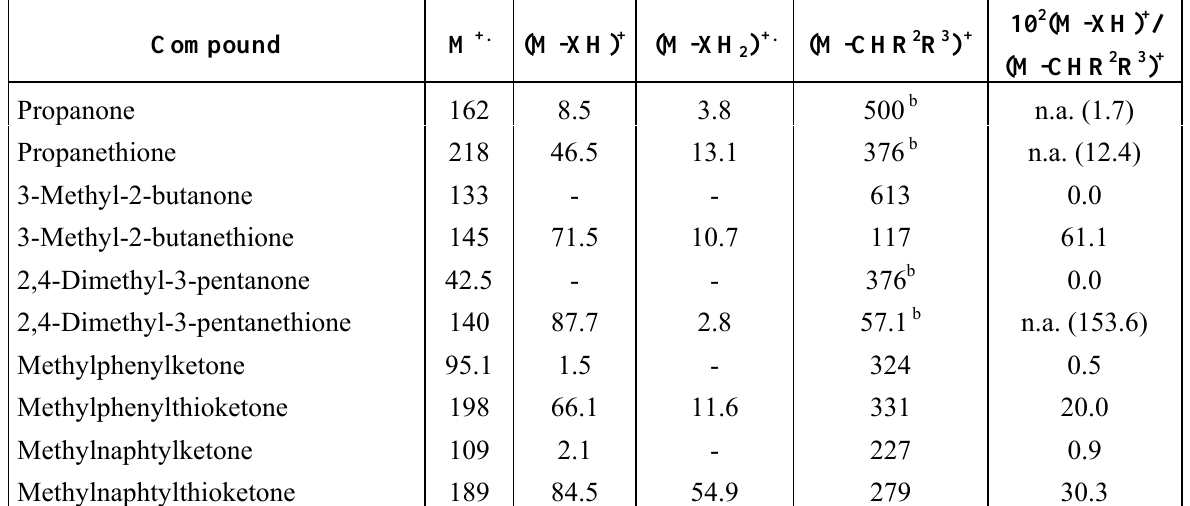
Table 2 . Relevant Mass Spectral Data for Selected Ketones and Thioketones a